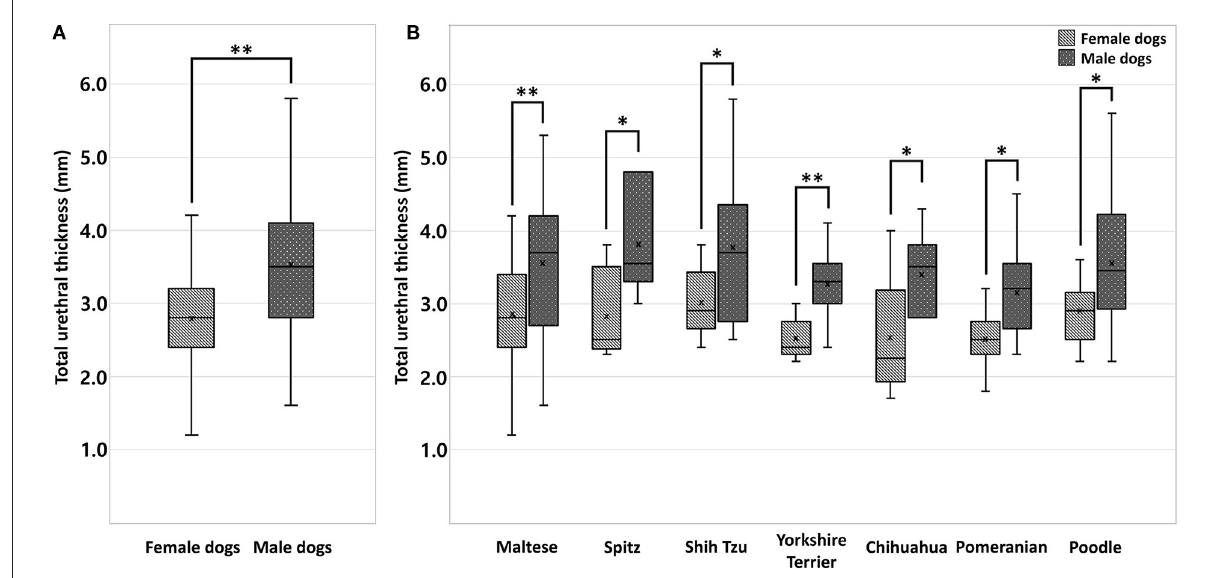
FIGURE3 Box-and-whisker plot (A) of total urethral thickness ranges in healthy small-breed dogs ( n = 240); female ( n = 120) and male dogs ( n = 120). A statistically significant difference in total urethral thickness was found between the sexes ( p < 0.001**). Box-and whisker plot (B) of total urethral thickness ranges in healthy small-breed dogs ( n = 240); Maltese ( n = 103, 52 females, 51 males), Spitz ( n = 12, 6 females, 6 males), Shih Tzu ( n = 25, 12 females, 13 males), Yorkshire Terrier ( n = 20, 10 females, 10 males), Chihuahua ( n = 13, 6 females, 7 males), Pomeranian ( n = 26, 13 females, 13 males), and Poodle ( n = 41, 21 females, 20 males). There were significant differences in total urethral thickness between sexes in the Maltese and Yorkshire Terrier breeds ( p < 0.001**) and in the Spitz, Shih Tzu, Chihuahua, Pomeranian, and Poodle breeds ( p < 0.05*).